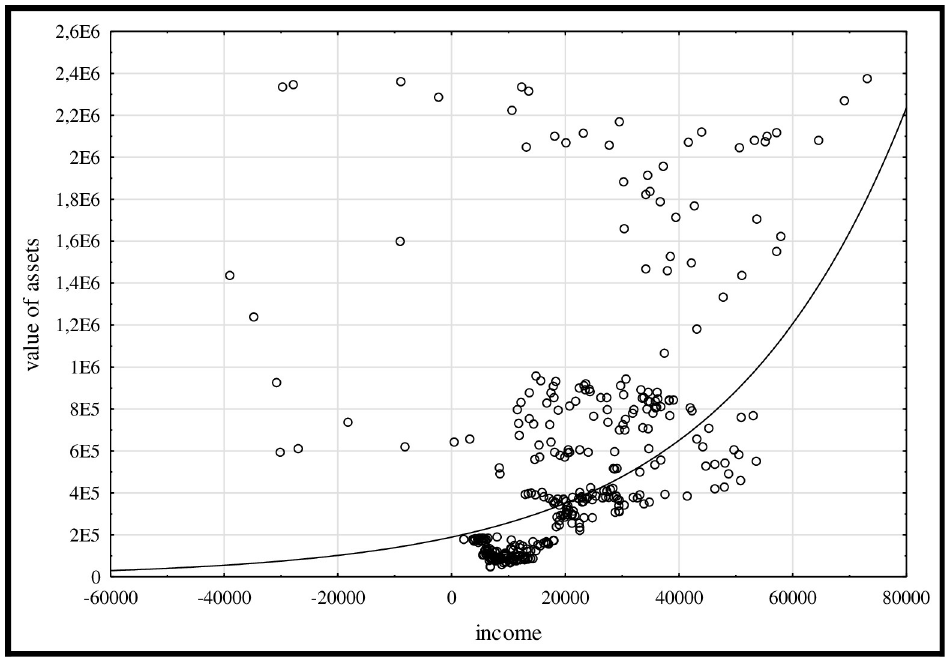
Fig 2. Graphical illustration of the relationship between income (EUR) and assets (EUR; e.g. 1,4E6 means 1,4x10 6 ) in farms (FADN system) in the EU countries (23) (2004–2018). Source: own calculation based on data of the FADN system (S1